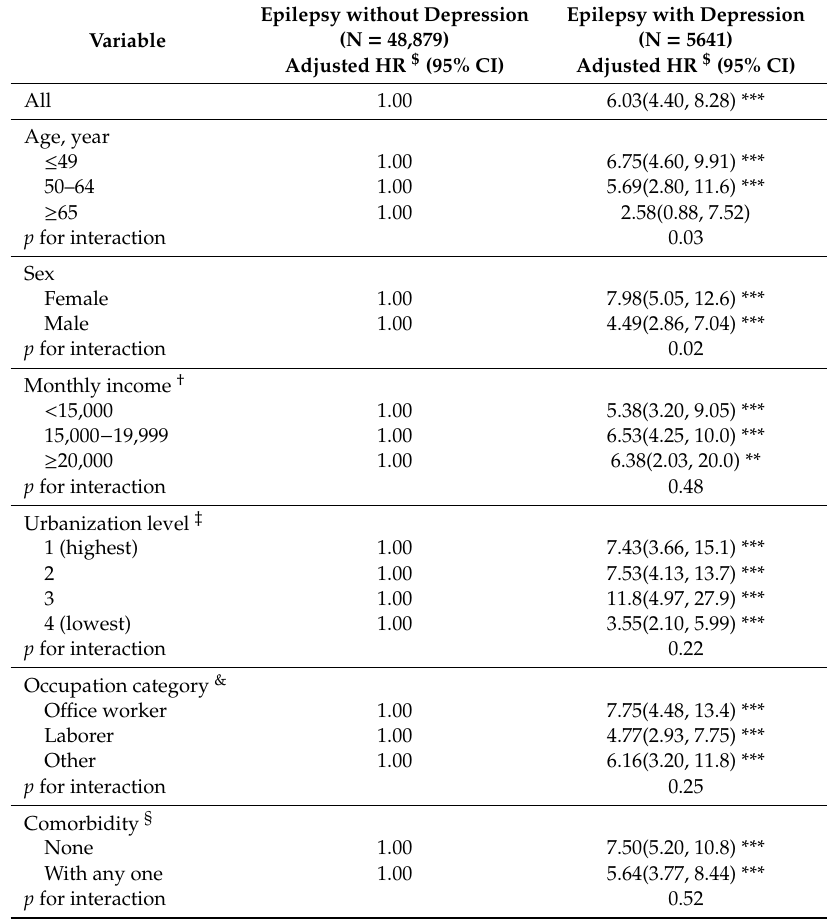
Table 4. Comparison of hazard ratios for suicide attempt stratified by age, sex, and comorbidities in patients with epilepsy with and without comorbid